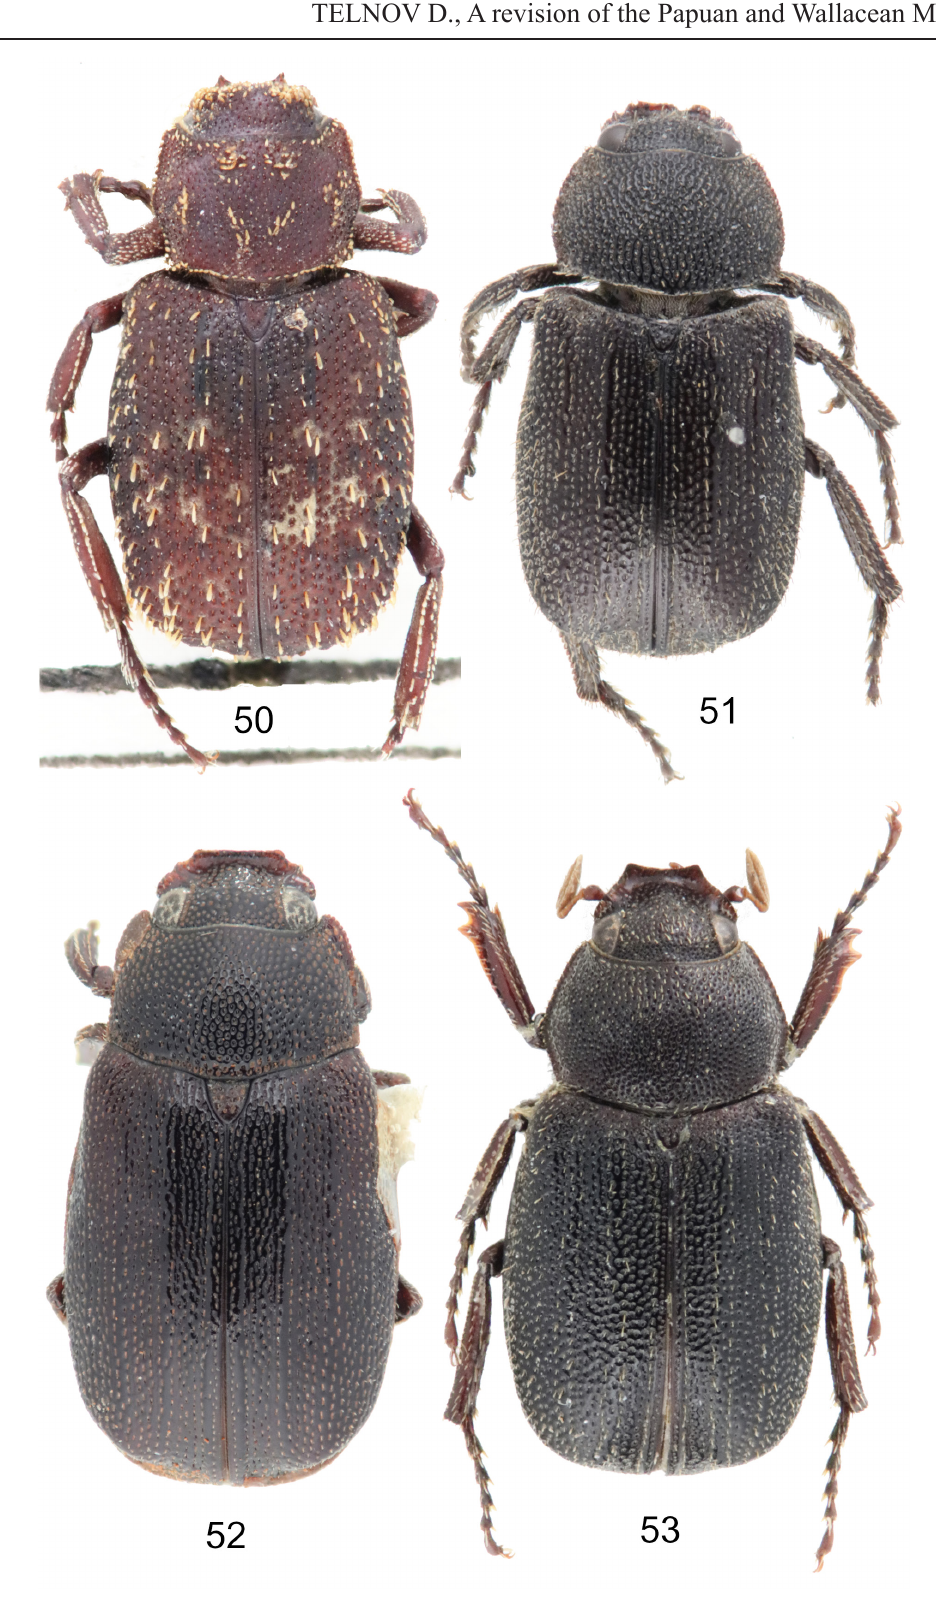
Figs 50–53. Papuan and Wallacean Maechidius Macleay, 1819, habitus, dorsal view. 50 . M. lapsus sp. nov., holotype, ♂ (BMNH). 51 . M. legalovi sp. nov., holotype, ♂ (BMNH). 52 . M. leucopsar sp. nov., holotype, ♂ (IECA). 53 . M. lineatopunctatus Frey, 1969, holotype, ♂ (NHMB). Not to